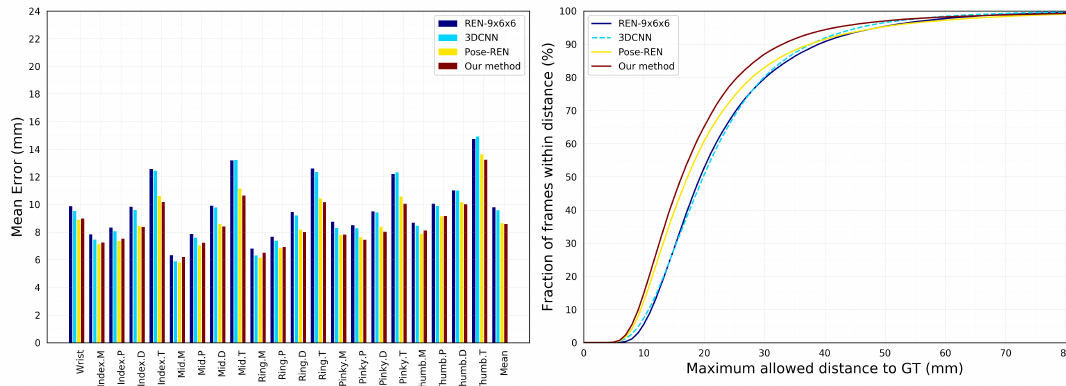
Figure 3. Our approach compares the latest benchmarks on MSRA dataset. Left : Each joint error. Right : The fraction of frames over different maximum Euclidean distance error thresholds. The large area below the curve indicates better results. Our proposed method performs best in the graph of discriminating methods. (Best viewed on screen).